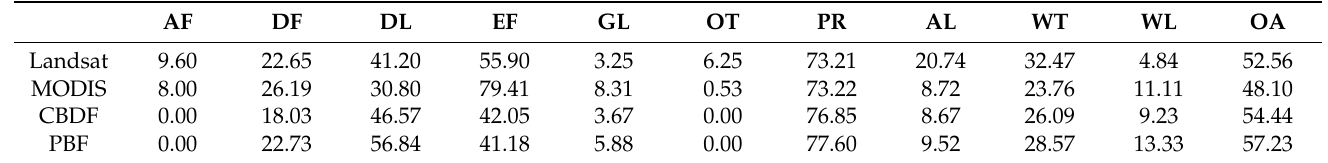
Figure 17. Fusion results using compromised decision fusion. Table 7. Comparison of the class-wise and overall classification accuracy (%) for each